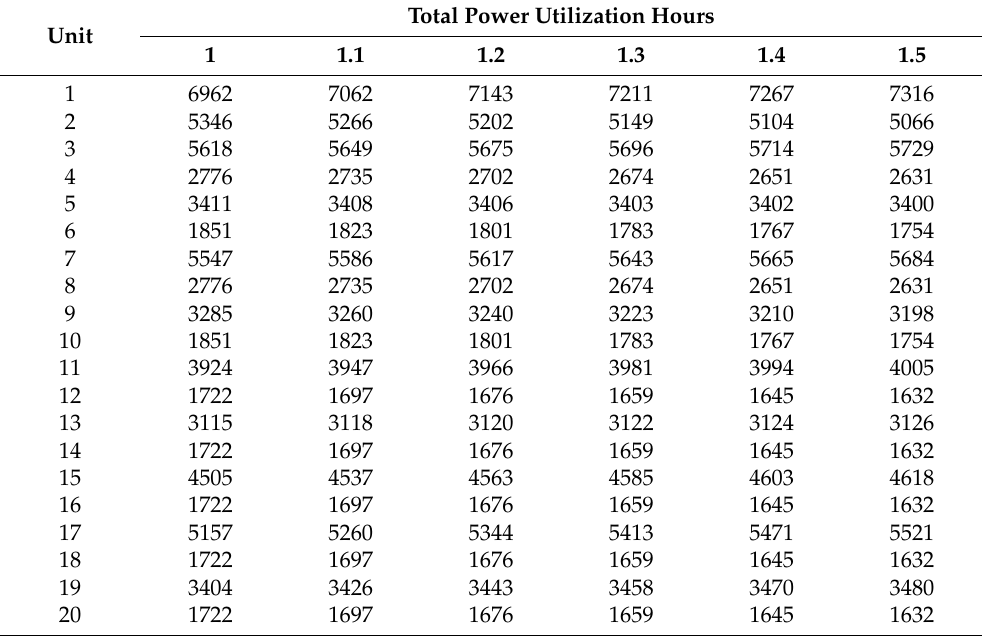
Table A8. Annual electric generation hour of each unit under different encouraged